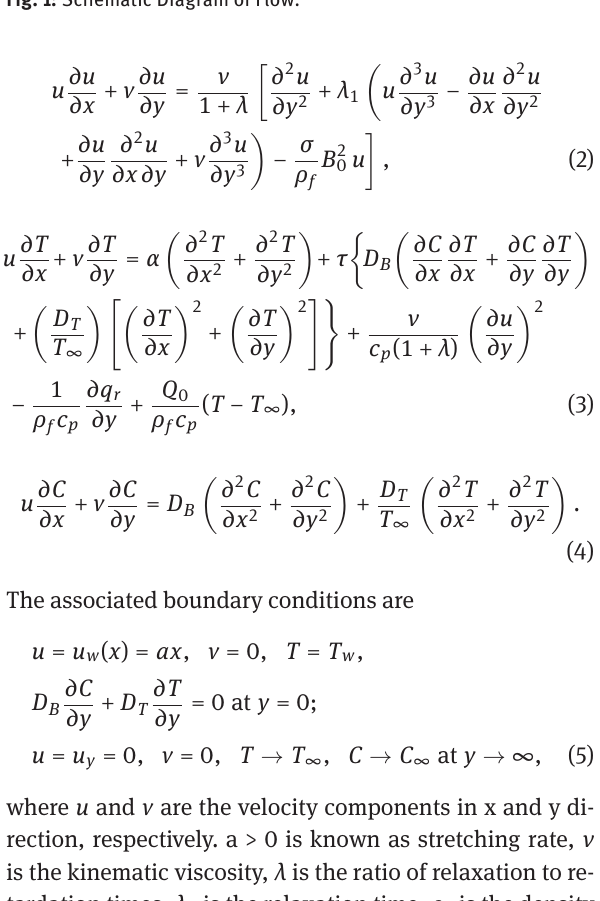
Fig. 1: Schematic Diagram of